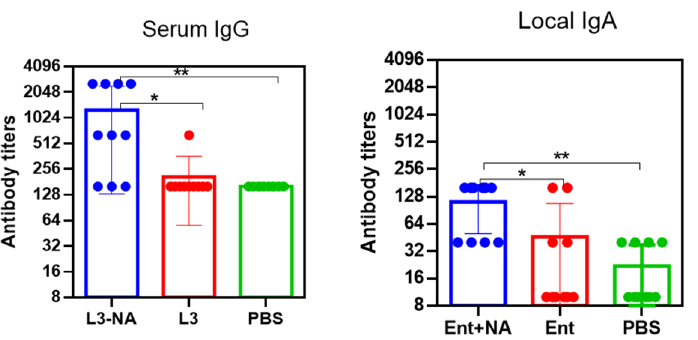
Figure 9. Immunogenicity in Balb/c mice 14 days after third feeding ( n = 10). Serum IgG and local IgA to whole purified A/California/07/09(H1N1)pdm09 influenza virus ( n = 10). * p < 0.05, ** p < 0.01.